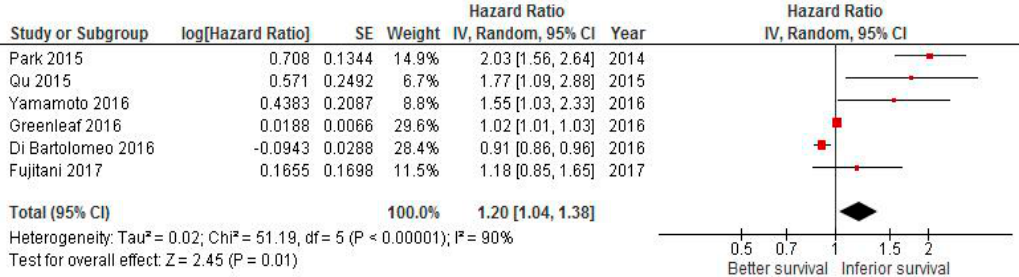
Figure 2. Forest plot of association between delay of adjuvant chemotherapy beyond 6–8 weeks and survival in gastric cancer.